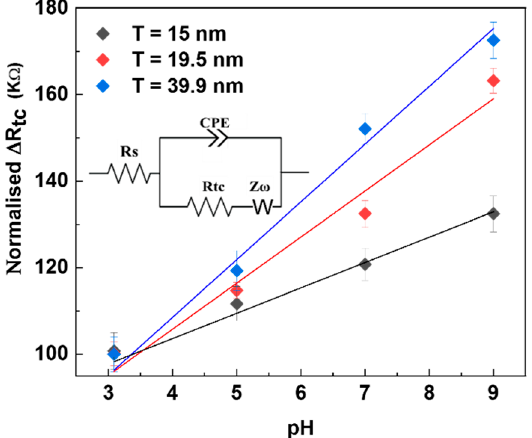
Figure 9. Calibration curve variation of normalized ∆ R ct as a function of the pH for different hafnium oxide thickness of 15.0 nm, 19.5 nm and 39.9 nm.